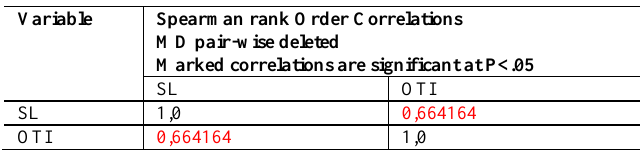
Table 1: Spearman’s rank-order correlation and test for